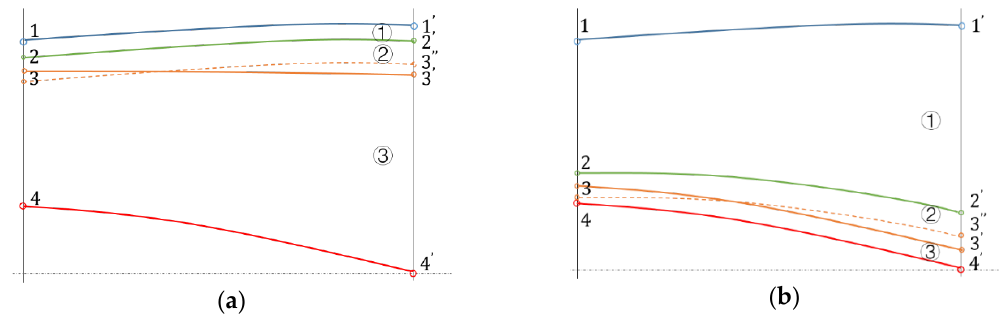
Figure 5. Schematic diagram of the pressure profile along the axial direction at several radial positions under conditions with increased total pressure drop. ( a ) Hot frit-dominated design; ( b ) cold frit-dominated design.